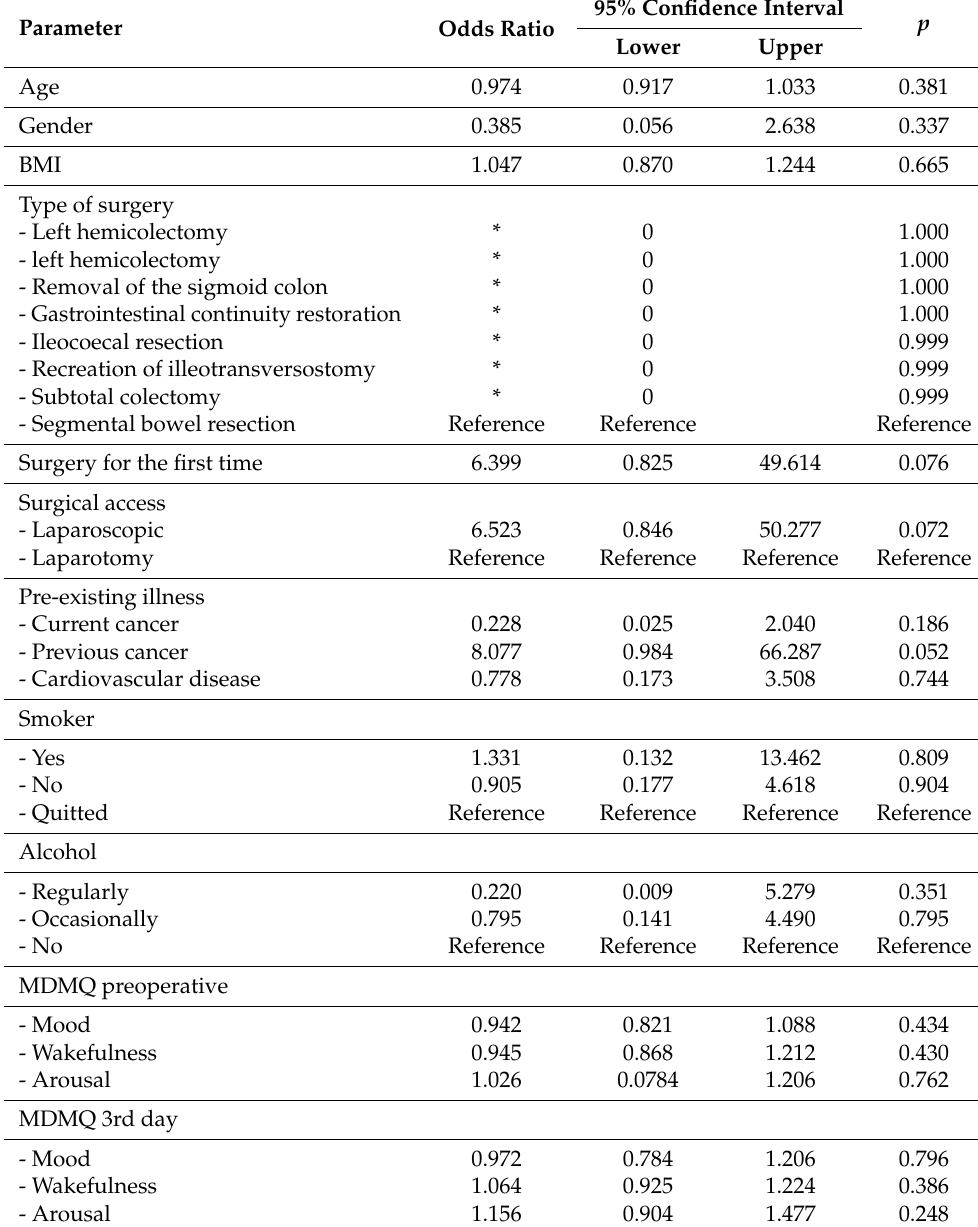
Table 4. Results of multivariable logistic regression: Influence of different factors on development of postoperative